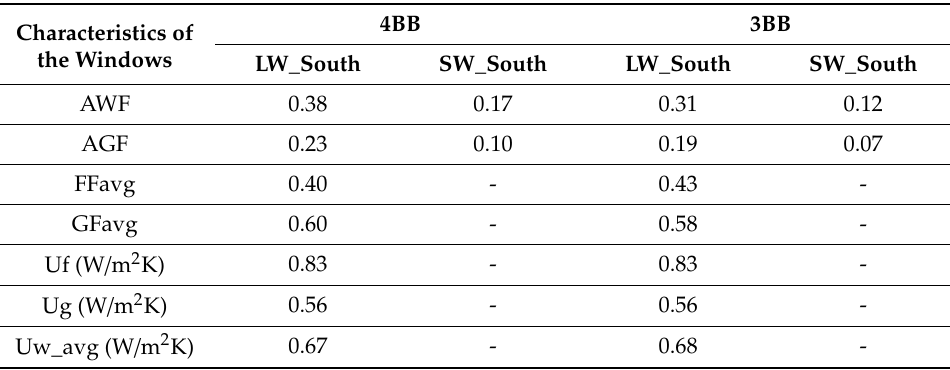
Table 1. Characteristics of the windows of the buildings.